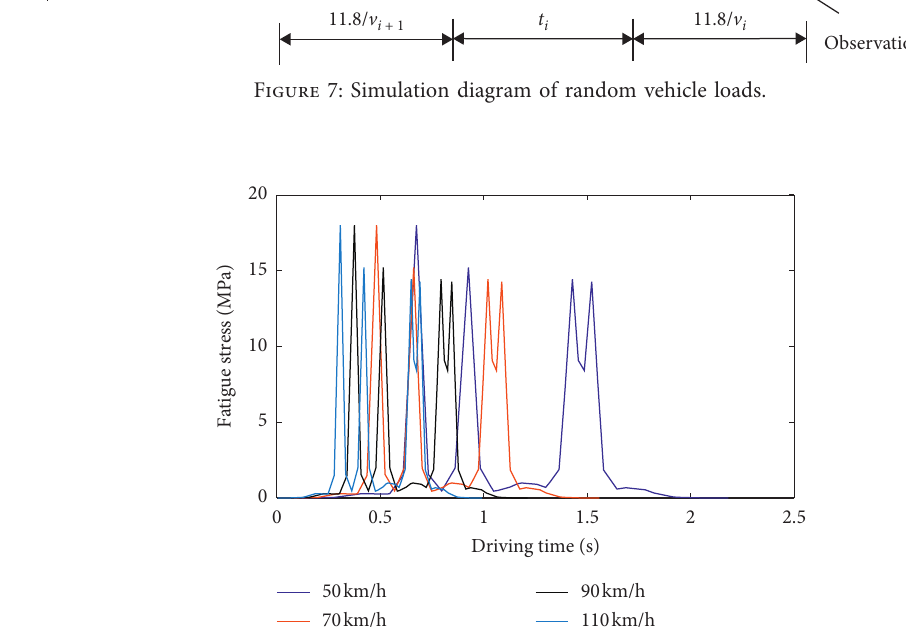
Figure 8: The fatigue stresses at different vehicle